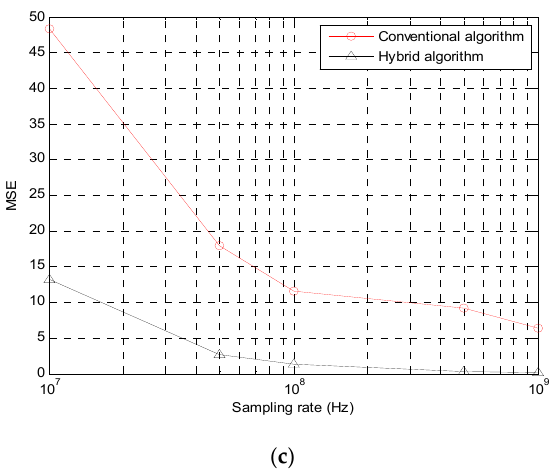
Figure 16. MSE curves for the estimated MS locations based on the proposed hybrid algorithm and the conventional algorithm, of the third scenario for (a) the first case, (b) the second case, and (c) the third case, for the second set.